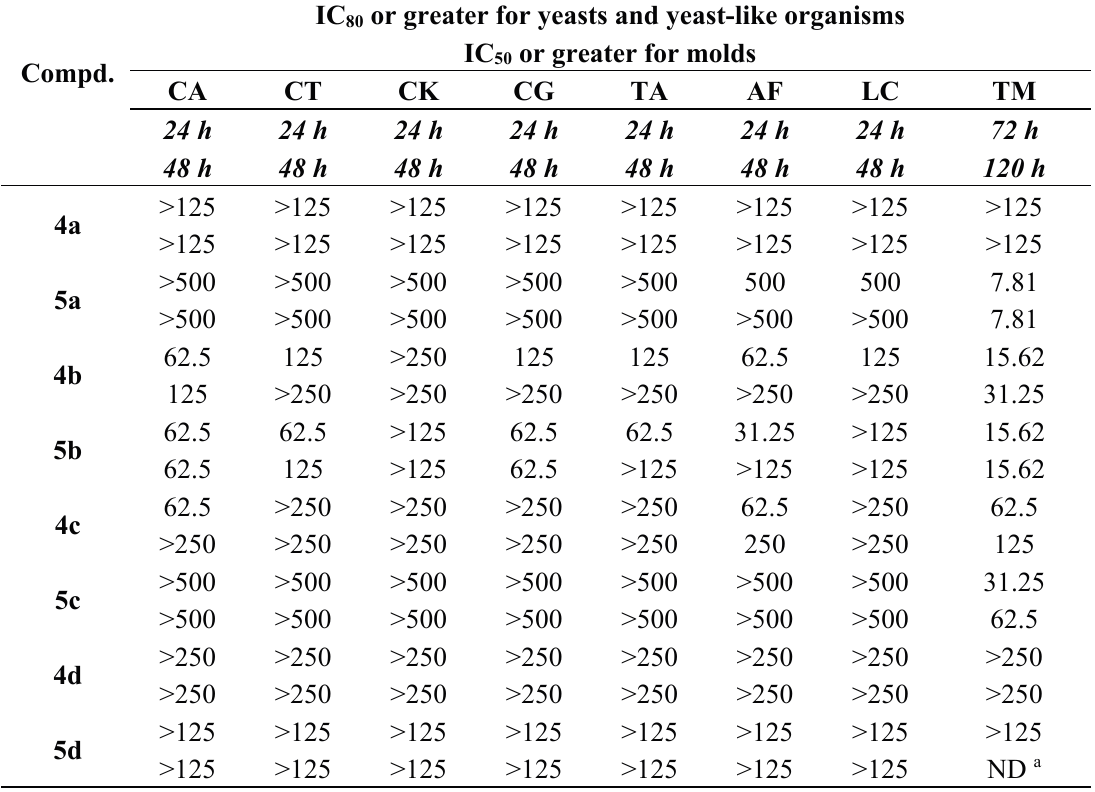
Table 1. Antifungal activity of isopropyl derivatives 4a – 4j and propyl derivatives 5a – 5j (compared to fluconazole, voriconazole and